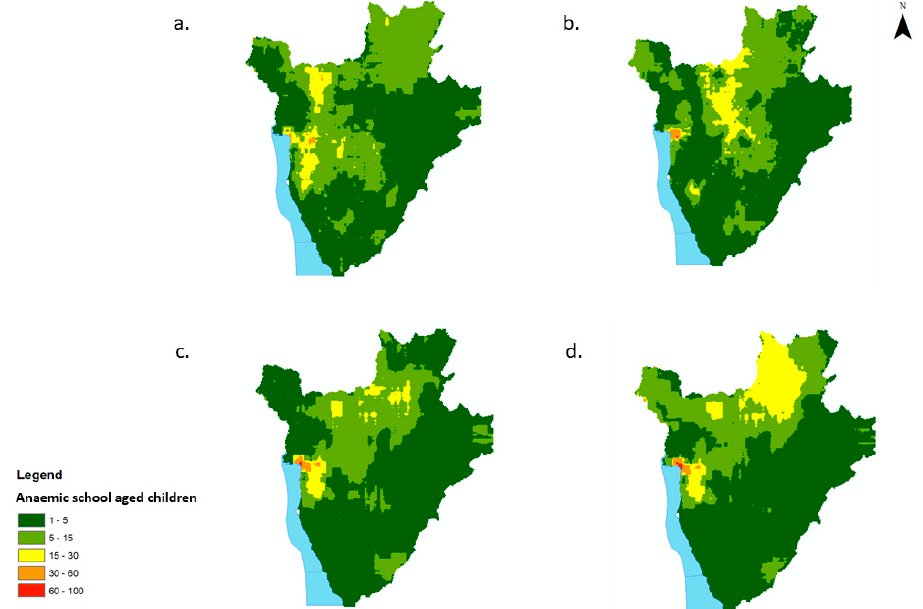
Figure 3. Predicted prevalence maps of low-severity anaemia per year for school-aged children (5–